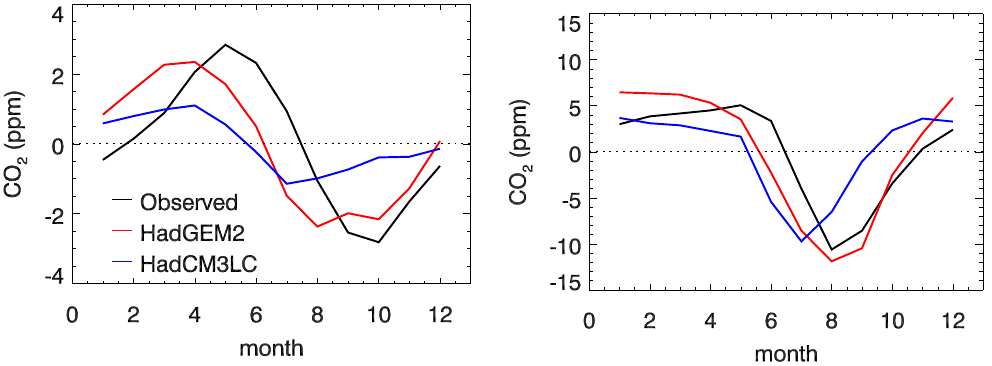
e t Fig. 21. Observed (Keeling et al., 2008; black) and simulated seasonal cycles of atmospheric CO 2 (in ppm) comparing HadGEM2-ES (red)